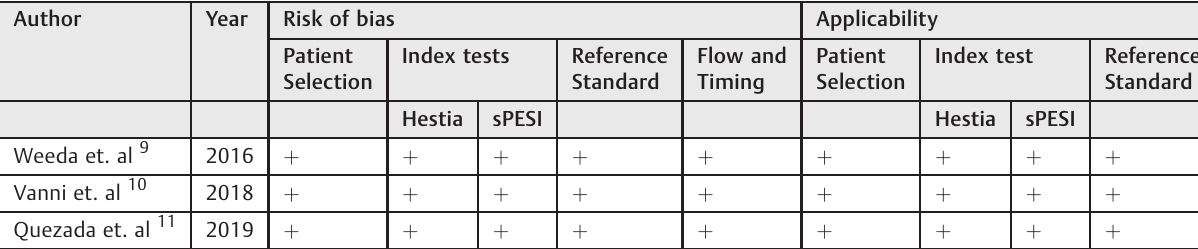
Table 2 Quality assessment by QUADAS-2 criteria